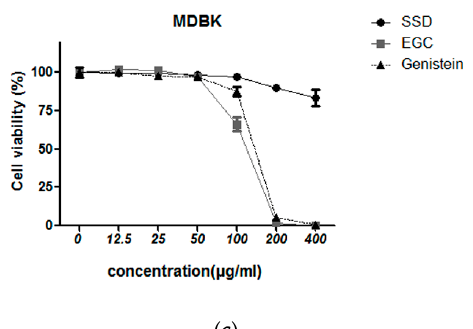
Figure 2. The cytotoxic effect of SSD. ( a ) U266, U937, THP-1, K562, CPAE, CCD-18Co, and MDBK cells were seeded into 96-well microplates and treated with the indicated concentrations of SSD for 24 h (sample number n = 3). ( b ) U266 and U937 cells were seeded into 96-well microplates and the indicated concentrations of SSD, EGC, and genistein were added for 24 h (sample number n = 3). EZ-CYTOX assay was used to measure cell viability. ( c ) MDBK cells were exposed to 0, 12.5, 25, 50, 100, 200, and 400 µg/mL of SSD, EGC, and genistein for 24 h (sample number n = 3). Results show a representative of three independent experiments. Results are presented as the means ± SD.